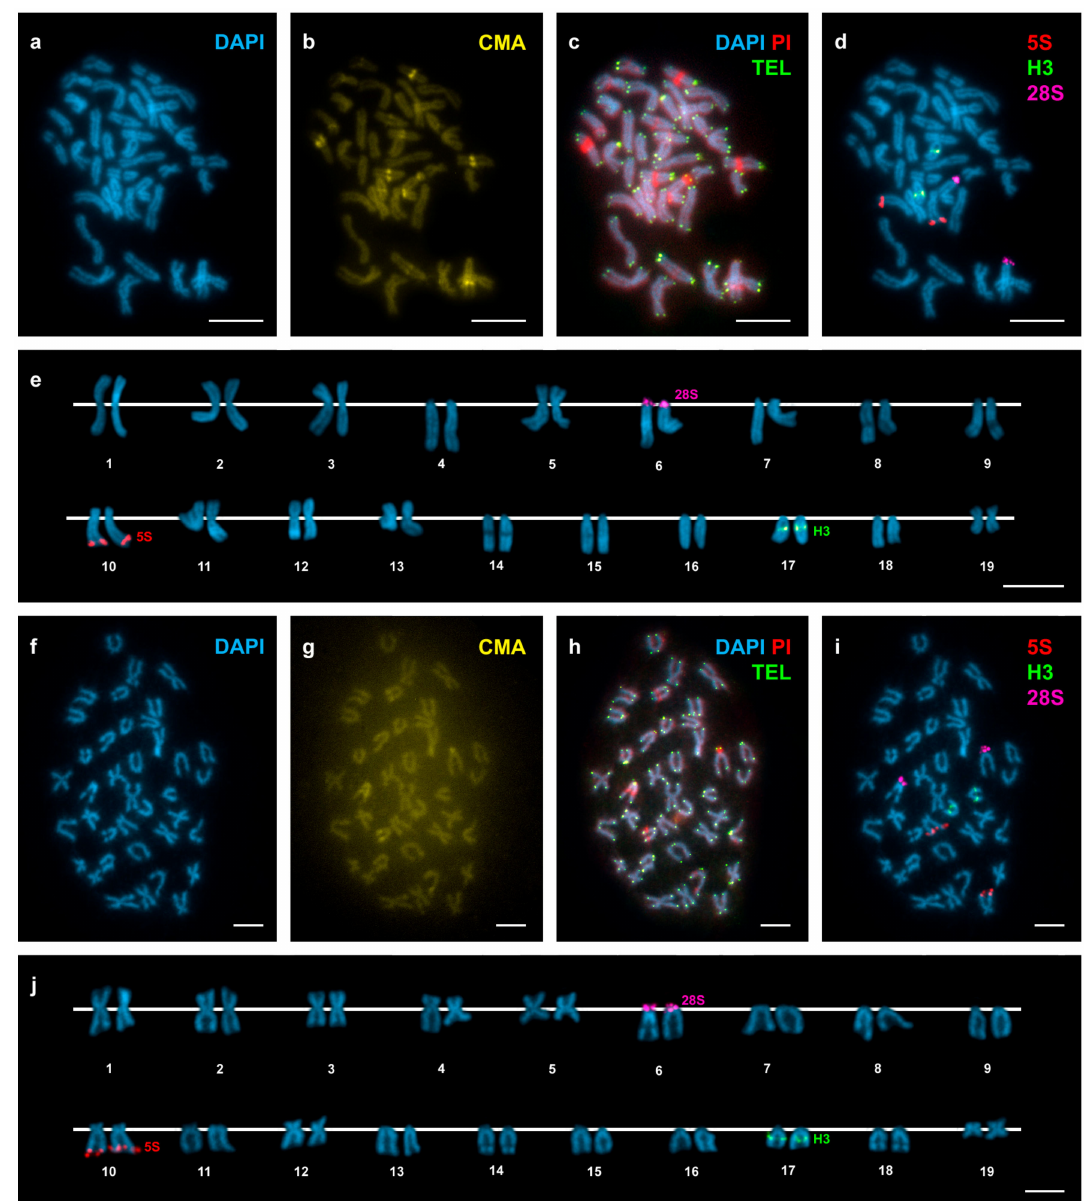
Figure 3. Mapping of telomeric sequence, 5S rDNA, 28S rDNA, and H3 histone gene clusters on Donax vittatus chromosomes. Sequential fluorochrome staining of mitotic metaphase plates shows DAPI-negative regions ( a , f ) that fluoresce yellow after CMA ( b , g ) and bright red after DAPI/PI ( c , h ) staining in Donax vittatus specimens from both Samil ( a – c ) and all the other Galician ( f – h ) populations. Hybridization of the same metaphase plates ( c , h ) with a telomeric PNA probe discloses signals (TEL, green) at both ends of every chromosome. Sequential FISH experiments using major and minor rDNA and H3 histone gene probes on the same metaphase plates ( d , i ), and the corresponding karyotypes ( e , j ), show H3 histone gene signals (H3, green) intercalated in the long arms of telocentric chromosome pair 17. Minor rDNA signals (5S, red) are subterminal to the long arms of subtelocentric chromosome pair 10. Major rDNA signals (28S, magenta) overlap the short arms of telocentric chromosome pair 6. Note the presence of 10 telocentric chromosome pairs in specimens from Samil (4, 6, 7, 8, 9, 14, 15, 16, 17 and 18) and 11 in those from the remaining Galician populations (6, 7, 8, 9, 11, 13, 14, 15, 16, 17 and 18). Scale bars, 5 µ